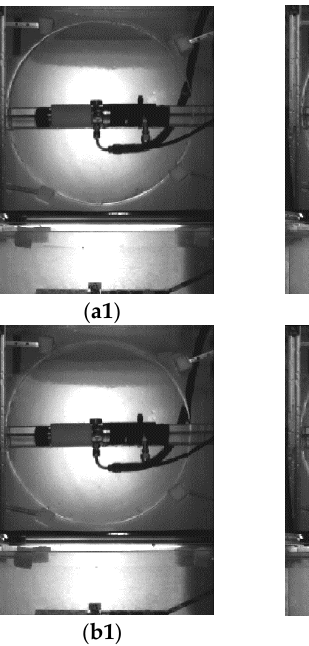
Figure 13. The damage patterns of ice under airgun bubble loads with the same condition H = 0.75, T = 0.30 ( P 0 = 2.44 MPa, h = 70 mm, t ice = 20 mm). ( a1 ) t = 0.00 ms, ( a2 ) t = 0.90 ms, ( a3 ) t = 4.50 ms, ( a4 ) t = 25.00 ms, ( b1 ) t = 0.00 ms, ( b2 ) t = 0.90 ms, ( b3 ) t = 4.50 ms, ( b4 ) t = 25.00 ms.